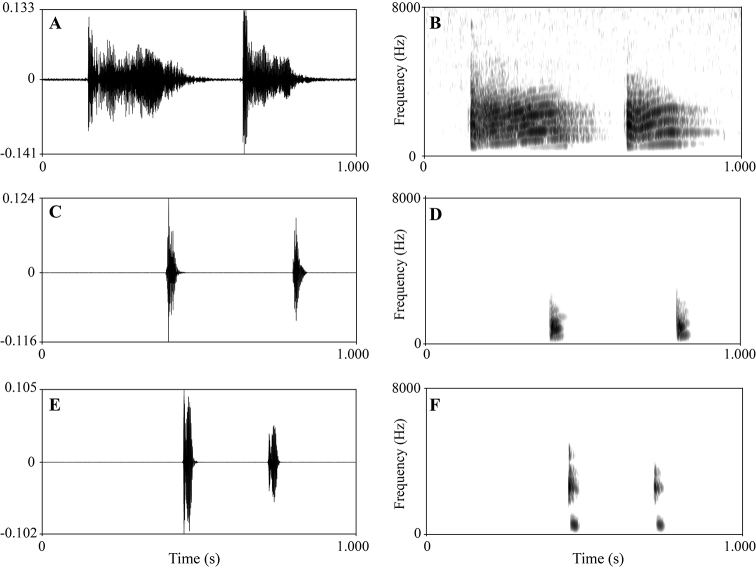
Advertisement calls of Nidirana
yeae sp. nov. (holotype CIBTZ20190608004), N.
daunchina (specimen CIB2011081603) and N.
yaoica (specimen SYS a007009). A Waveform showing two-note call of Nidirana
yeae sp. nov B sonogram showing two-note call of Nidirana
yeae sp. nov C waveform showing two-note call of N.
daunchinaD sonogram showing two-note call of N.
daunchinaE waveform showing two-note call of N.
yaoicaF sonogram showing two-note call of N.
yaoica.